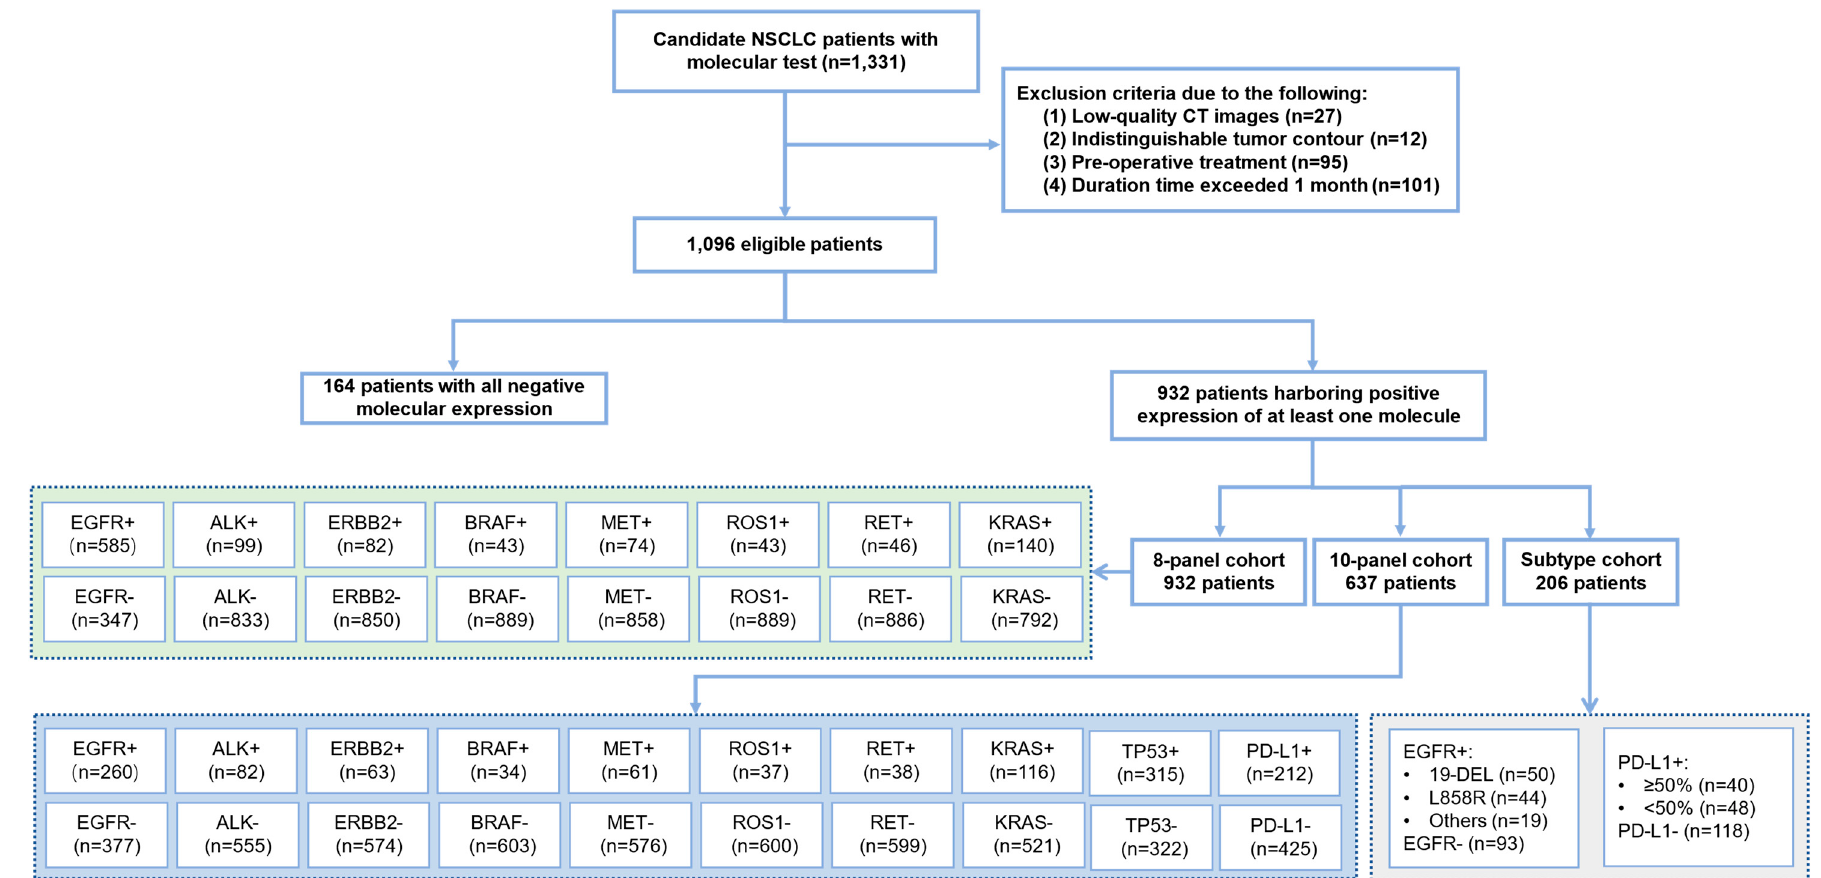
Figure 2. Illustration of cohort construction. Between April 2018 and June 2020, this study included a primary cohort of 1331 consecutive patients with NSCLC who visited West China Hospital of Sichuan University for model development and validation. Patients whose specimens underwent histological staining or were used for molecular testing (8-panel, 10-panel and subtype) were used to evaluate the performance of our models on binary classification of molecular status (positive and negative), prediction of multiple molecular alterations and classification of subtype. ‘+’ indicates positive type while ‘-’ means negative type.